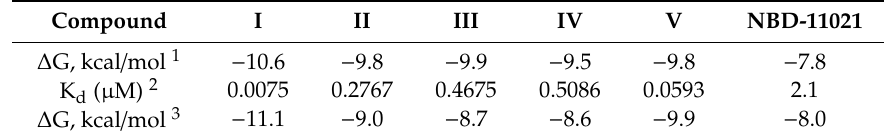
Table 3. Values of binding free energy ( ∆ G) and K d calculated for the PM7-based complexes of the identified compounds and NBD-11021 with